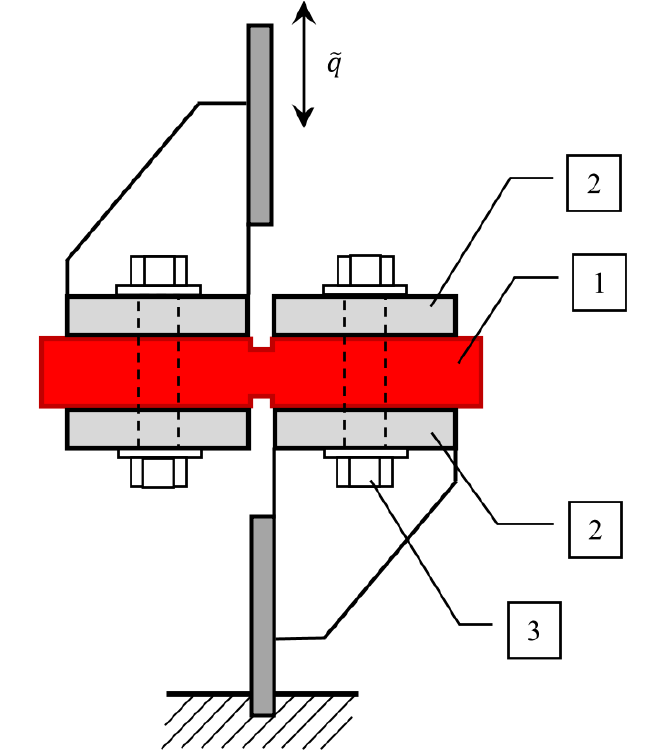
Figure 8. Special device to hold the sample in the transverse shear test. 1—VE material layer, 2—Steel sheets, 3—Clamping screw.